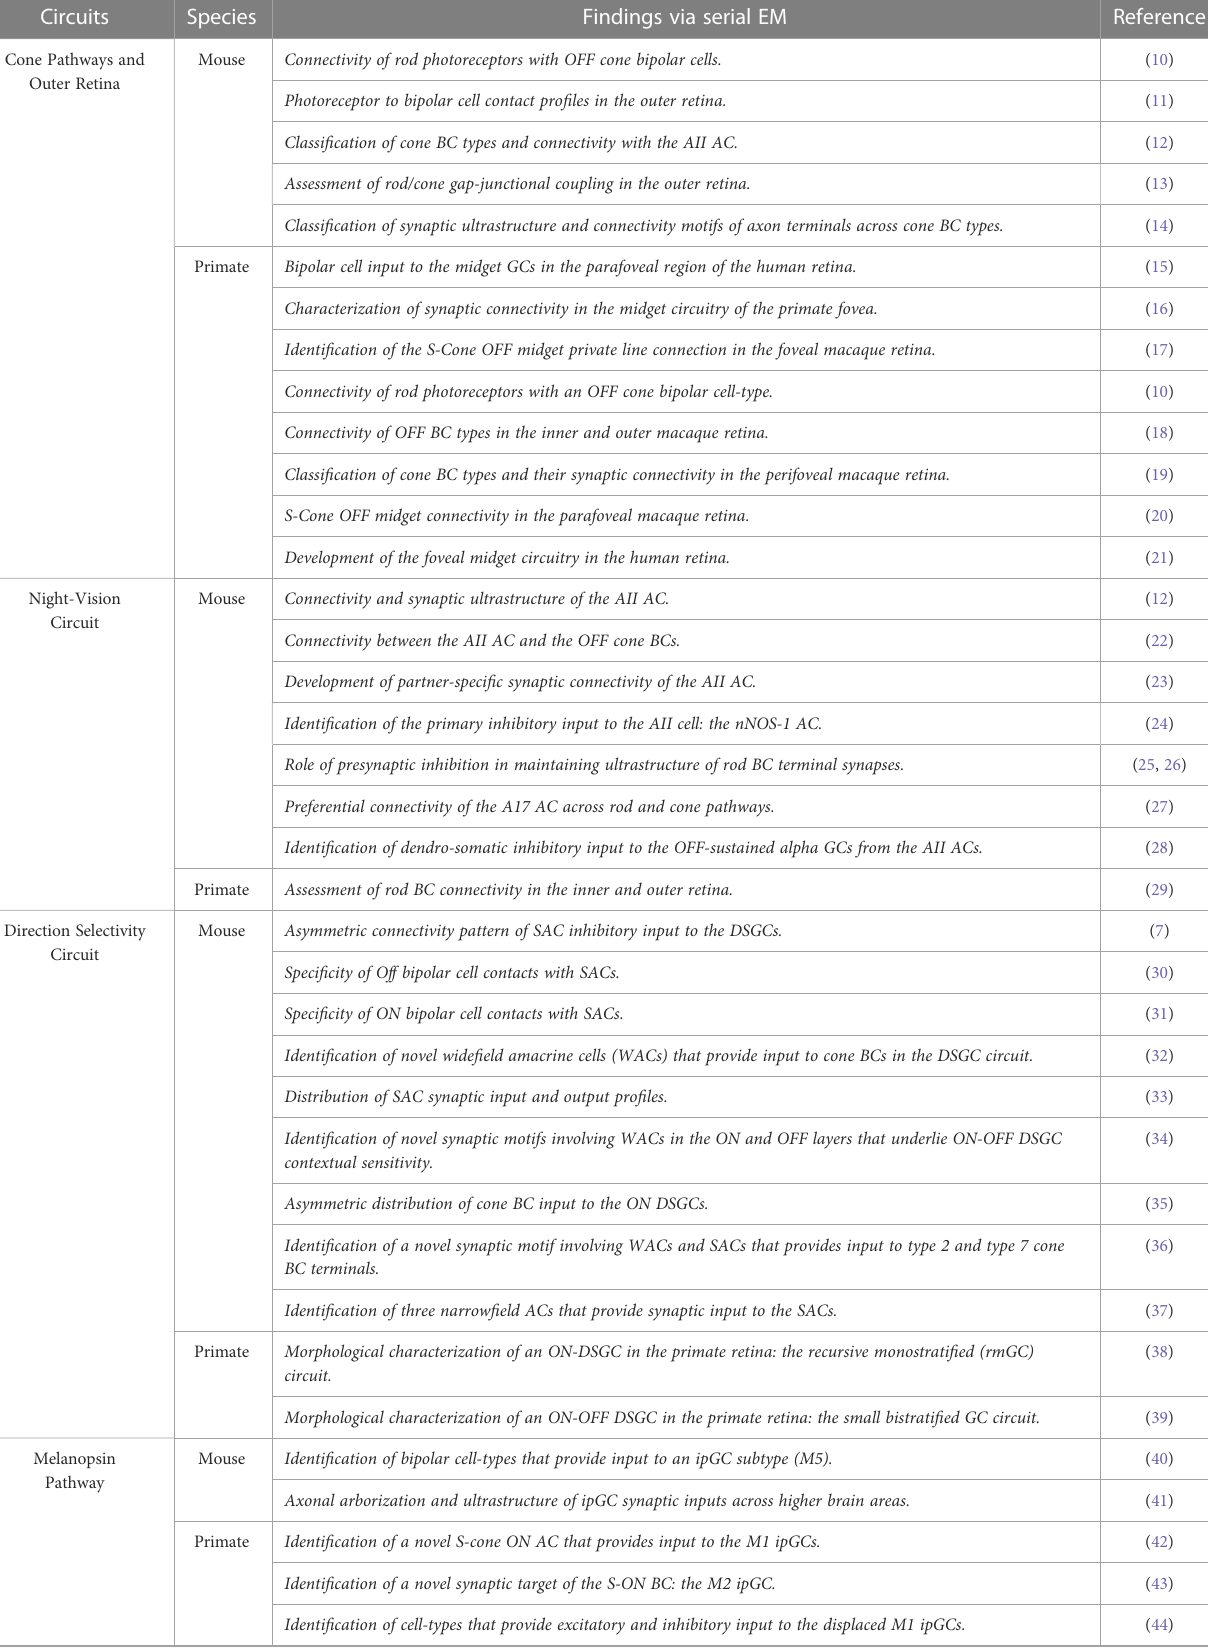
TABLE 1 Table summarizing some of the advances in retinal circuitry through serial EM reconstructions. Circuits Species Findings via serial EM Reference Cone Pathways and Outer